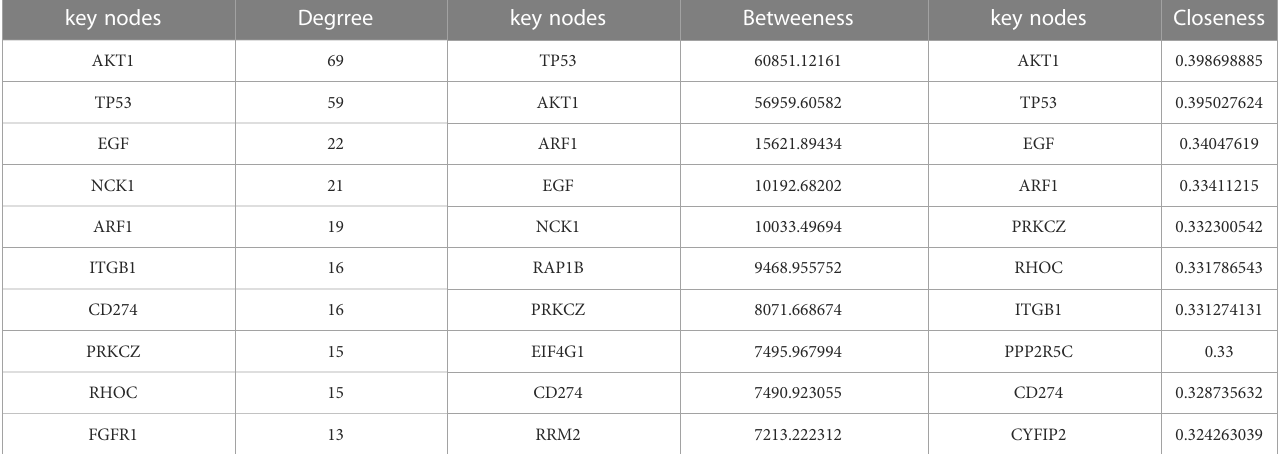
TABLE 2 Top 10 differential genes ranked by degree, betweenness and closeness values.